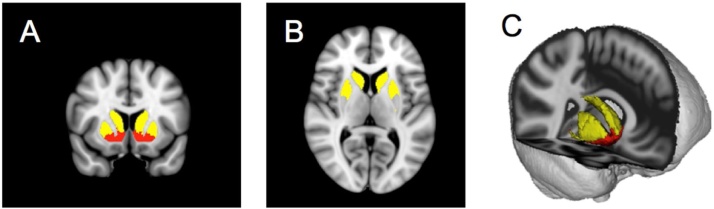
Bilateral regions of interest (ROIs) used in all imaging analyses were based on functional masks (Oxford–GSK–Imanova Striatal Connectivity Atlas). (A) Nucleus accumbens (red), dorsal striatum (yellow). (B) Dorsal striatum axial view. (C) Three-dimensional view of both ROIs with ventral striatum (red) and dorsal striatum (yellow). (For interpretation of the references to colour in this figure legend, the reader is referred to the web version of this article).